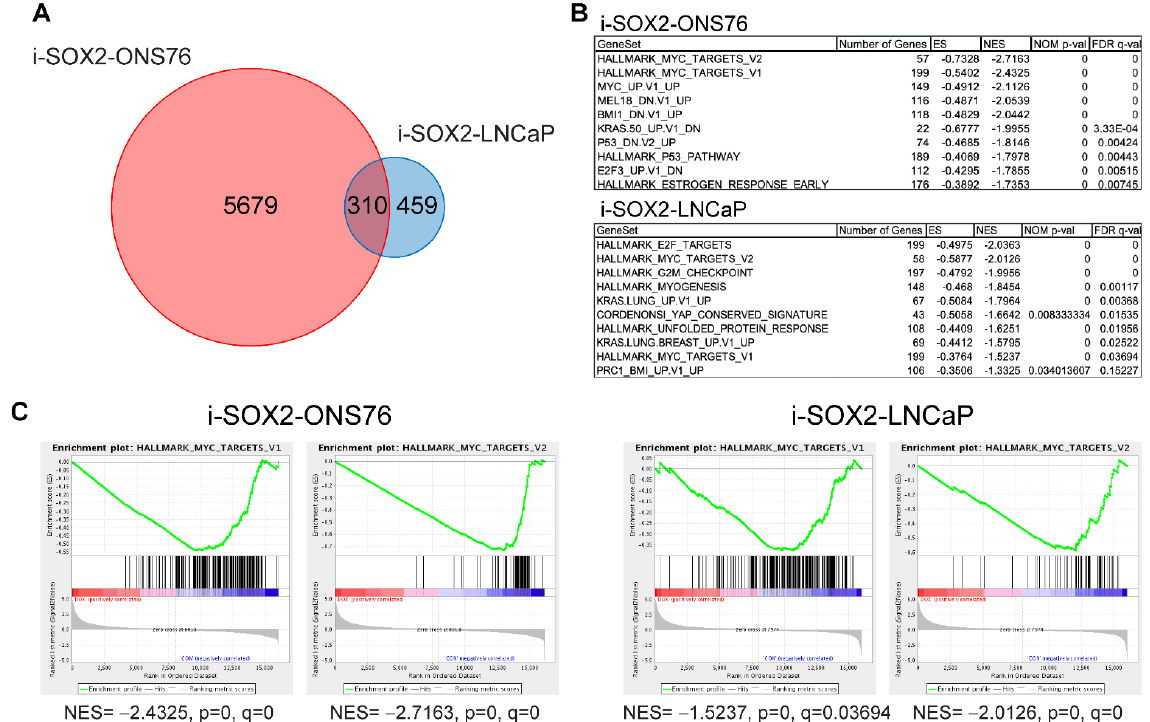
Figure 1. RNA-seq analysis of i-SOX2-ONS76 and i-SOX2-LNCaP cells. ( A ) Venn diagram of differentially expressed genes (DEGs) between i-SOX2-ONS76 and i-SOX2-LNCaP cells. ( B ) Top 10 downregulated GSEA gene sets when SOX2 is elevated in i-SOX2-ONS76 and i-SOX2-LNCaP cells. ( C ) Gene set enrichment plots for MYC target genes in i-SOX2-ONS76 and i-SOX2-LNCaP.